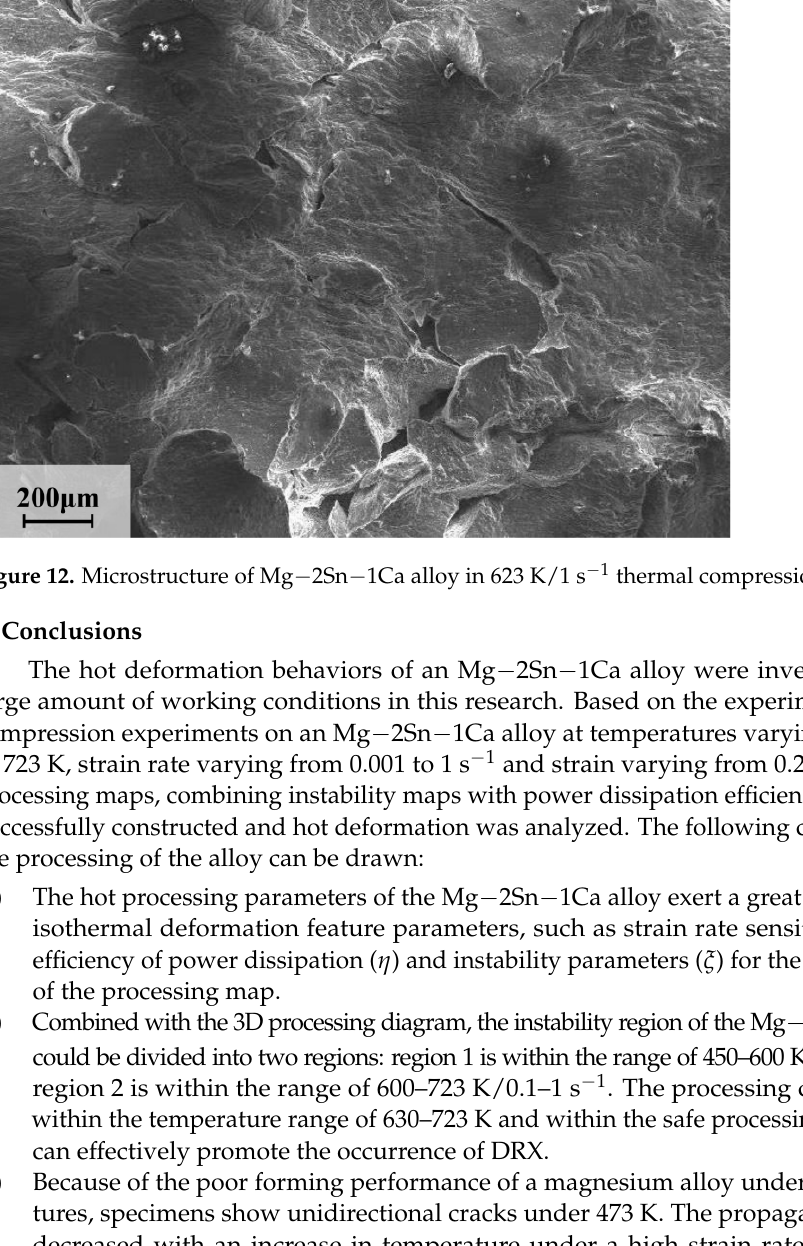
11 of 13 Figure 11. The microstructure of an Mg − 2Sn − 1Ca alloy in 423 K/1 s − 1 thermal compression. ( a ) The crack of the specimen; ( b ) Fracture surface; ( c ) local magnification of crack. At a high strain rate, crack propagation decreased with the increase in temperature. Figure 12 shows that only fish scale cracks appeared on the specimen when the strain rate is 1 s −1 and the temperature is higher. Obviously, the strain localization under a high strain rate could be avoided by increasing the deformation temperature, which will curve the occurrence of unidirectional cracks. The power dissipation value is nearly 20–30% under this condition shown in processing maps. The reason for the powerful ability of DRX is that the smaller deformation and dislocation density is not conducive to the nucleation of